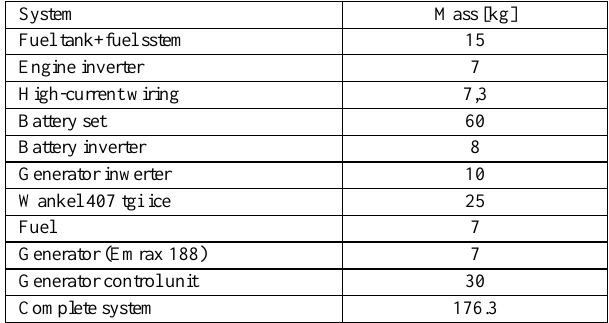
Table 5. Specifications of the hybrid battery set